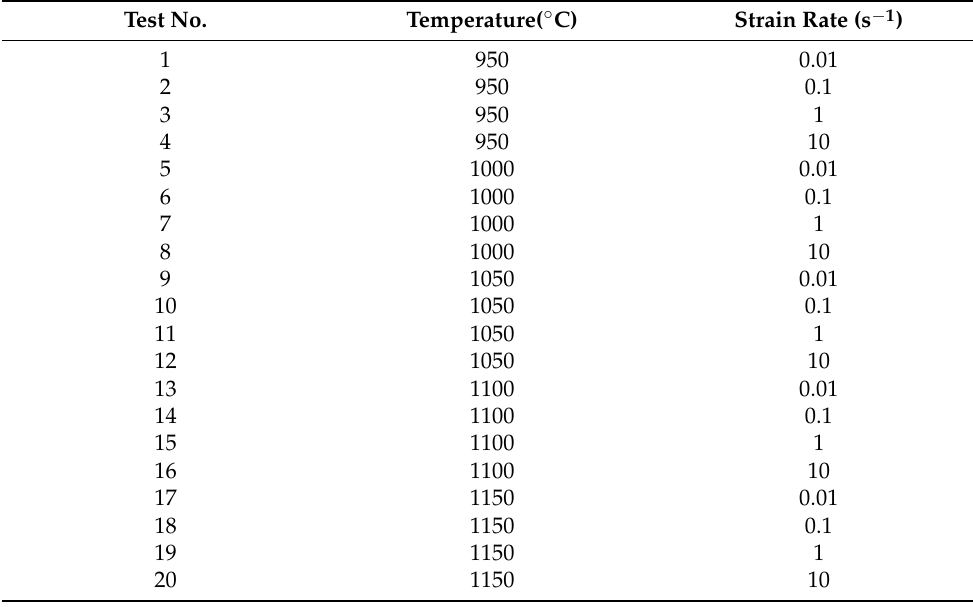
Table 1. Experimental